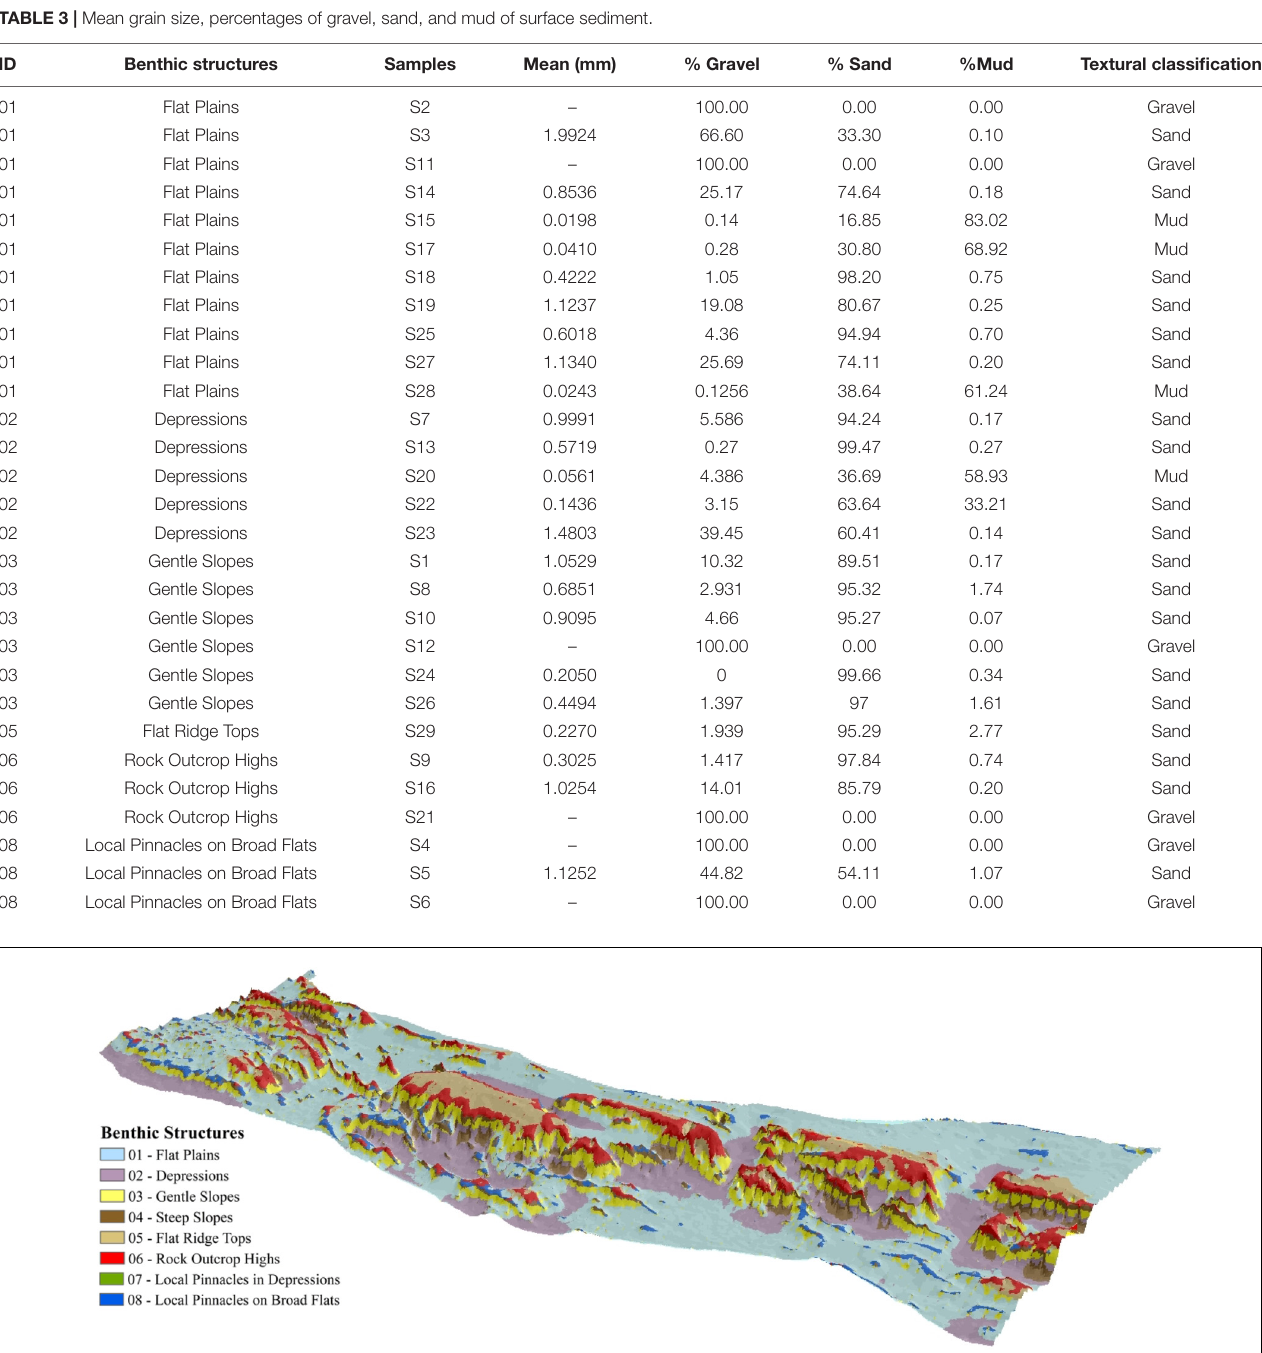
FIGURE 5 | Geomorphological classification/benthic structures of the study